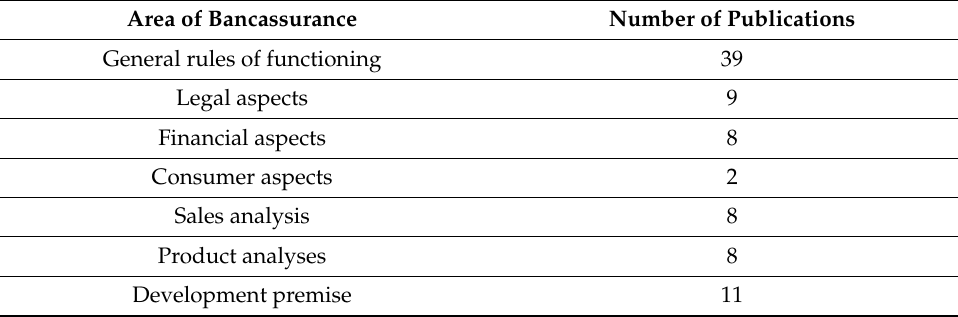
Table 2. Classification of articles with bancassurance as a